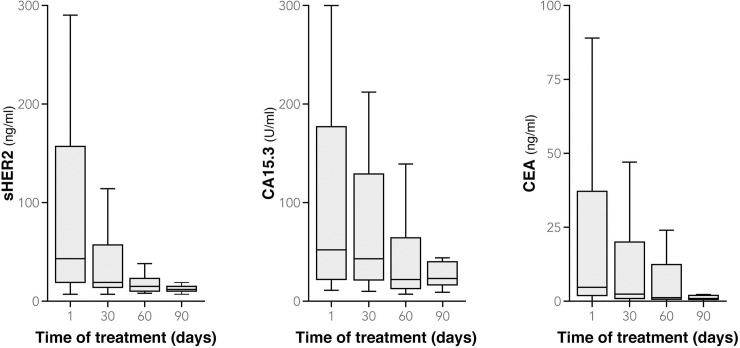
Boxplots of sHER2, CA15.3 and CEA levels at day 1, 30, 60 and day 90 (extreme values of biomarker levels are not represented but are included in the statistical analysis).